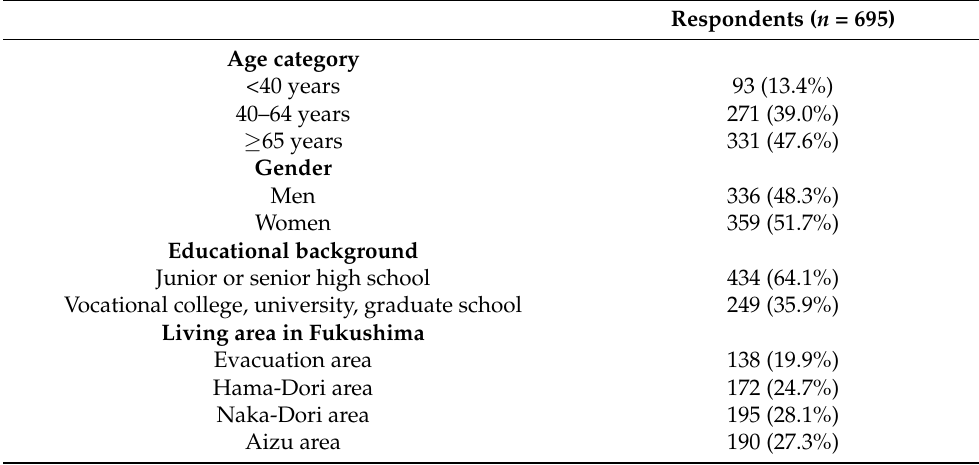
Table 1. Basic characteristics of respondents.